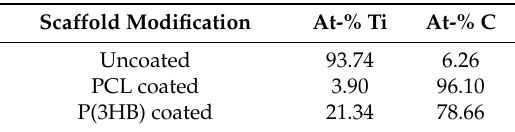
Table 3. Energy-dispersive X-ray (EDX) data on surface composition (atomic percentage (At-%) for the relevant elements titanium (Ti) and carbon (C)) of the coated porous titanium scaffolds.